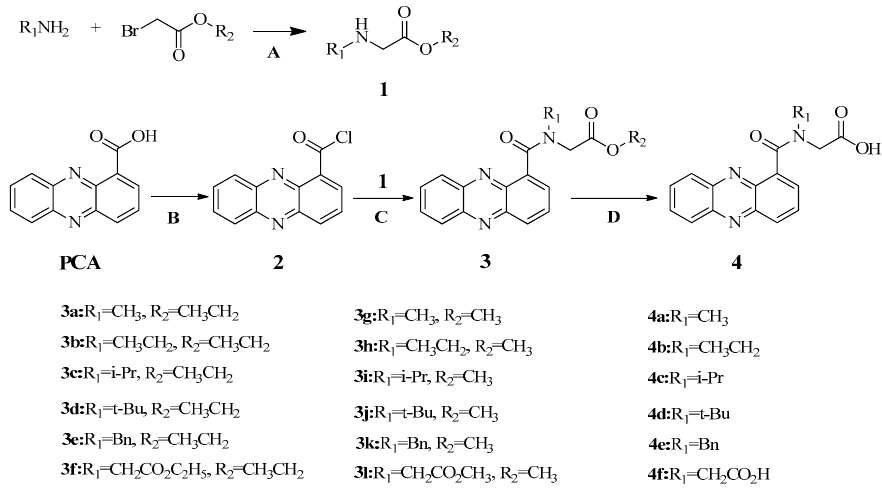
Figure 5. Structures of PCA-L-Tryptophan, PCA-L-Tyrosine, and PCA-Gly .